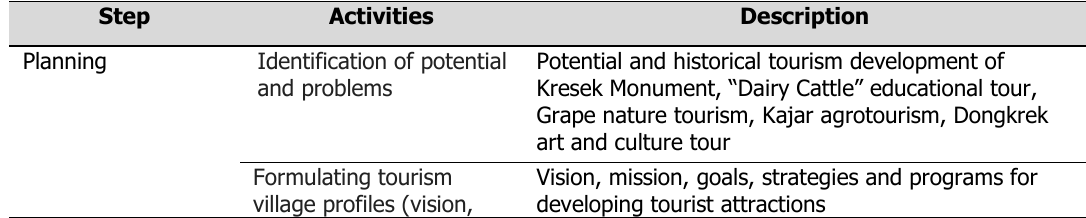
Table 1. The Stages of the CBT Implementation Strategy in Kresek Village